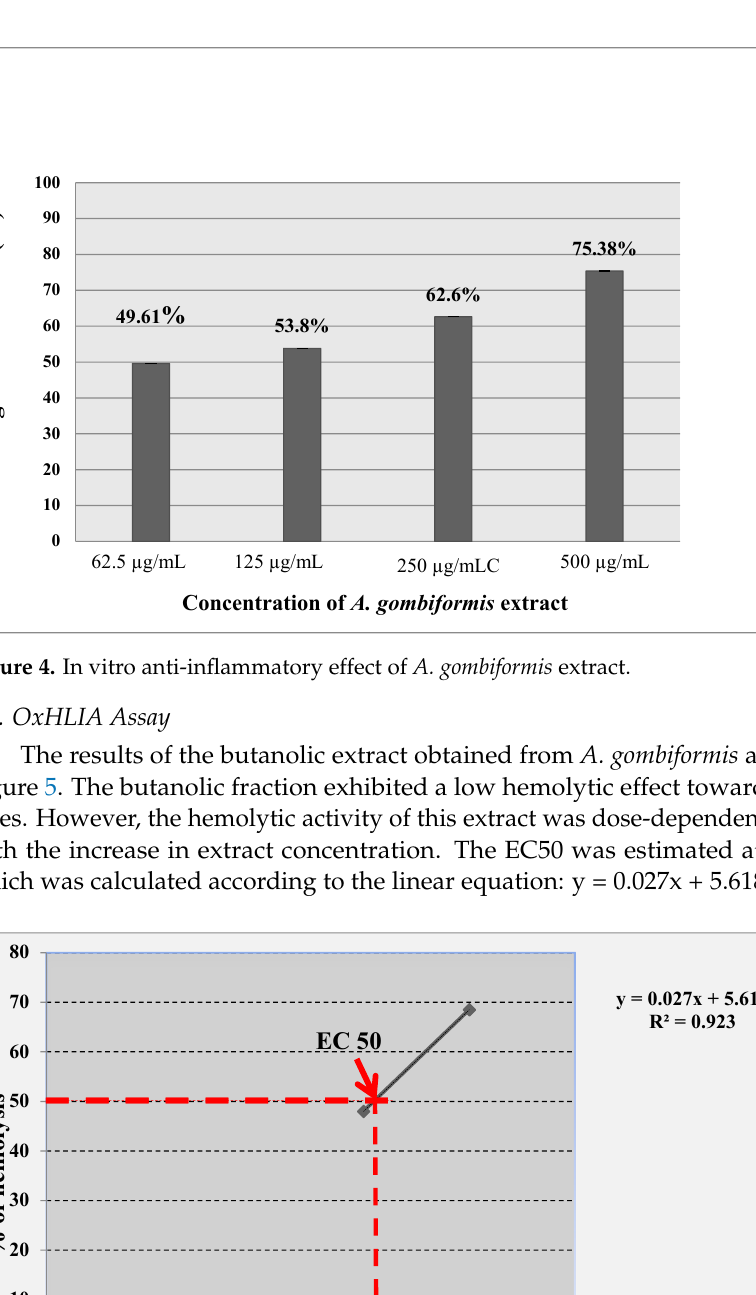
Figure 3. In vitro anti-inflammatory effect of diclofenac (Standard 1) and ketoprofen (Standard 2).